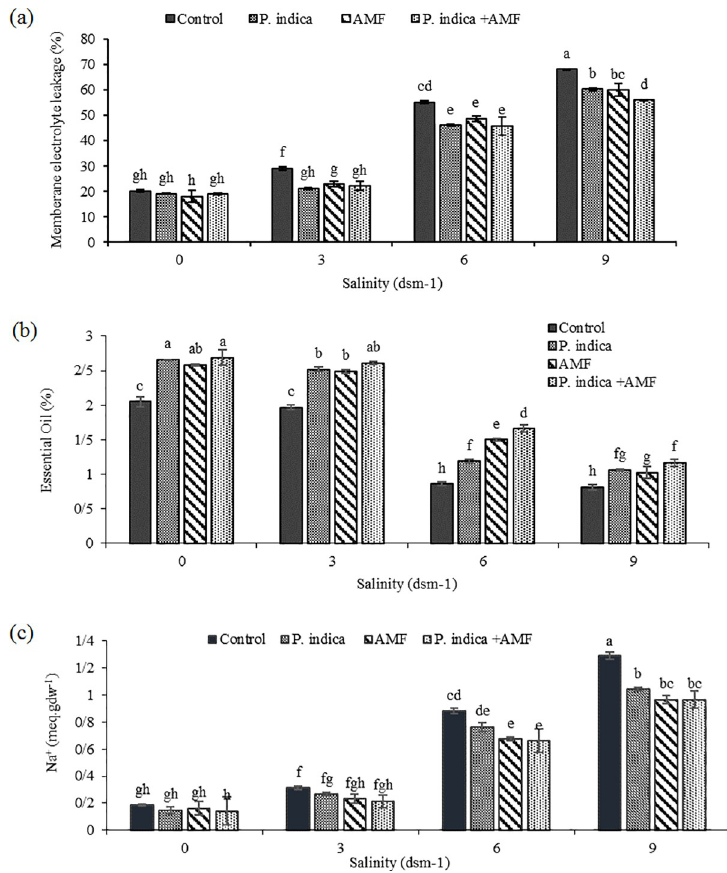
Fig 4. Effect of salinity on Membrane electrolyte leakage (a), Essence (b) and Na (c) in inoculated and non-inoculated peppermint with ( P . indica AMF and